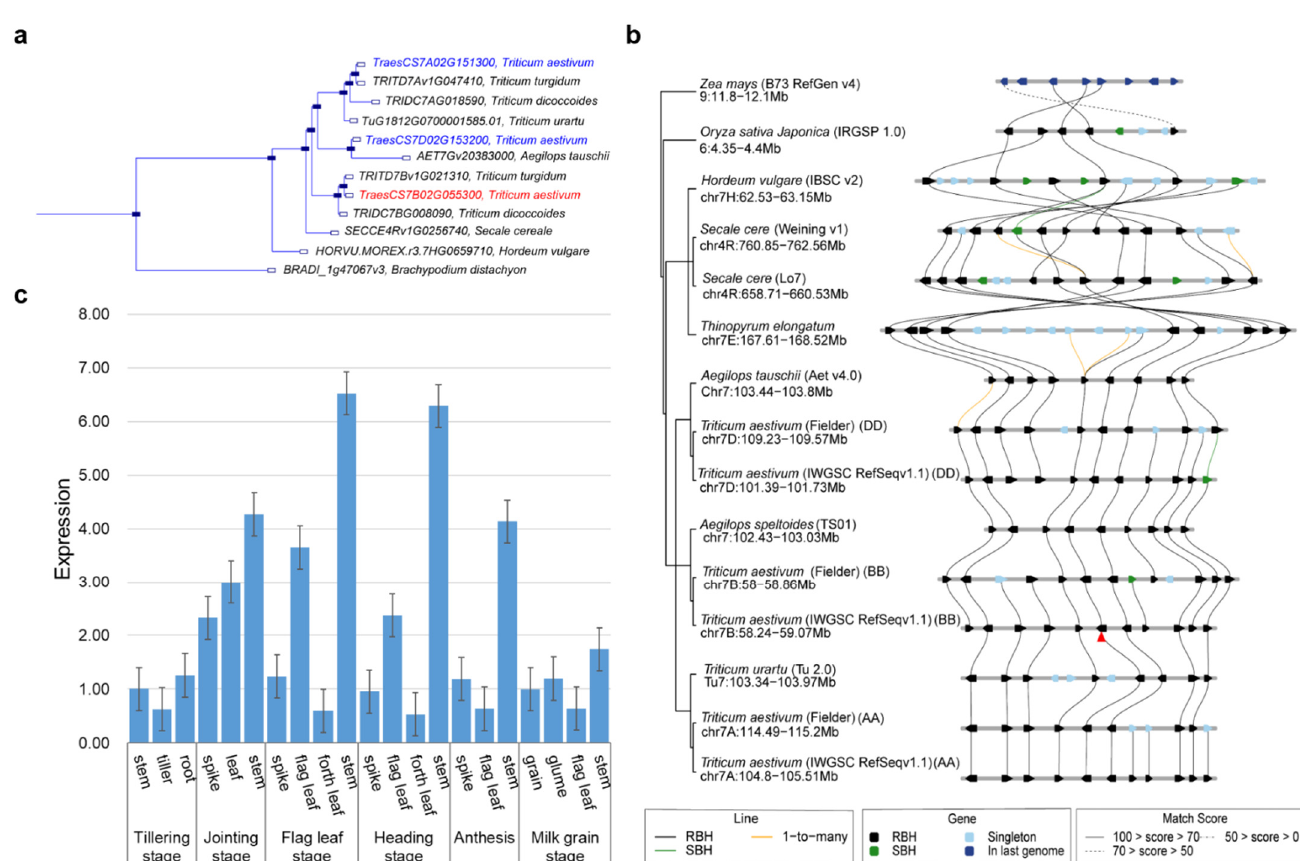
Figure 3. Characteristics of TaDHL-7B . ( a ) Phylogenetic tree for TaDHL-7B. ( b ) Collinearity analysis. ( c ) Expression levels of TaDHL-7B in different tissues and periods. Red triangle refers to the gene TaDHL-7B in subfigure b.